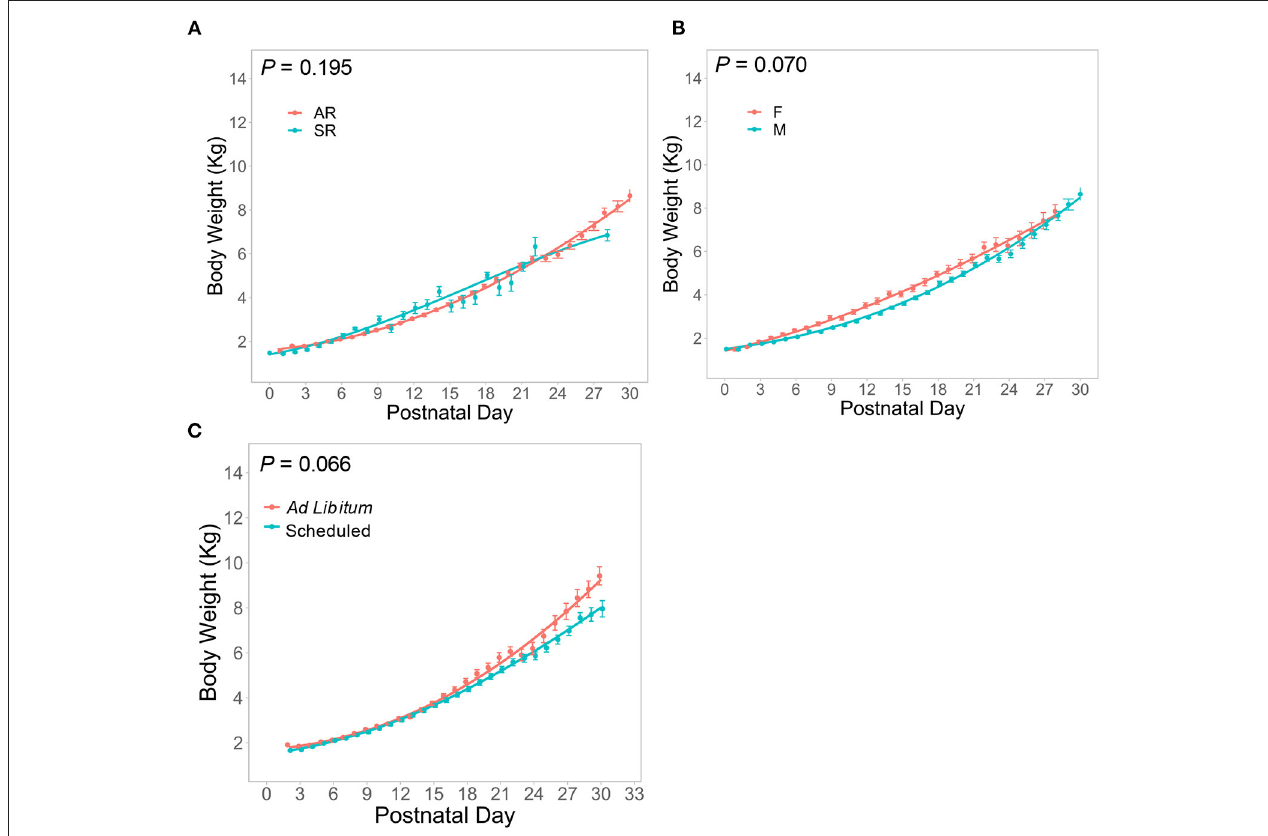
FIGURE 4 | Body Weight data as a function of PND from the Control group are plotted for (A) artificially reared (AR) and sow-reared (SR) pigs, (B) female (F) and male (M) pigs, and (C) ad libitum- and scheduled-fed pigs, demonstrating very similar growth patterns across these groups between PND 0 and